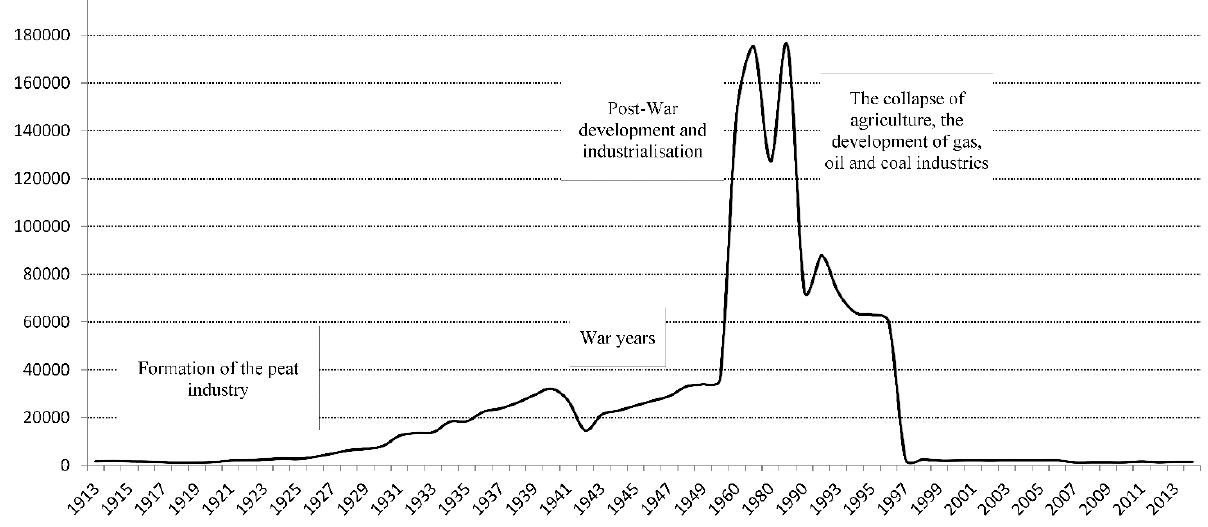
Figure 2. The dynamics of peat extraction in Russia during the period 1913‒2014. Units: thousand tonnes. Sources: Markov (2012) and USGS